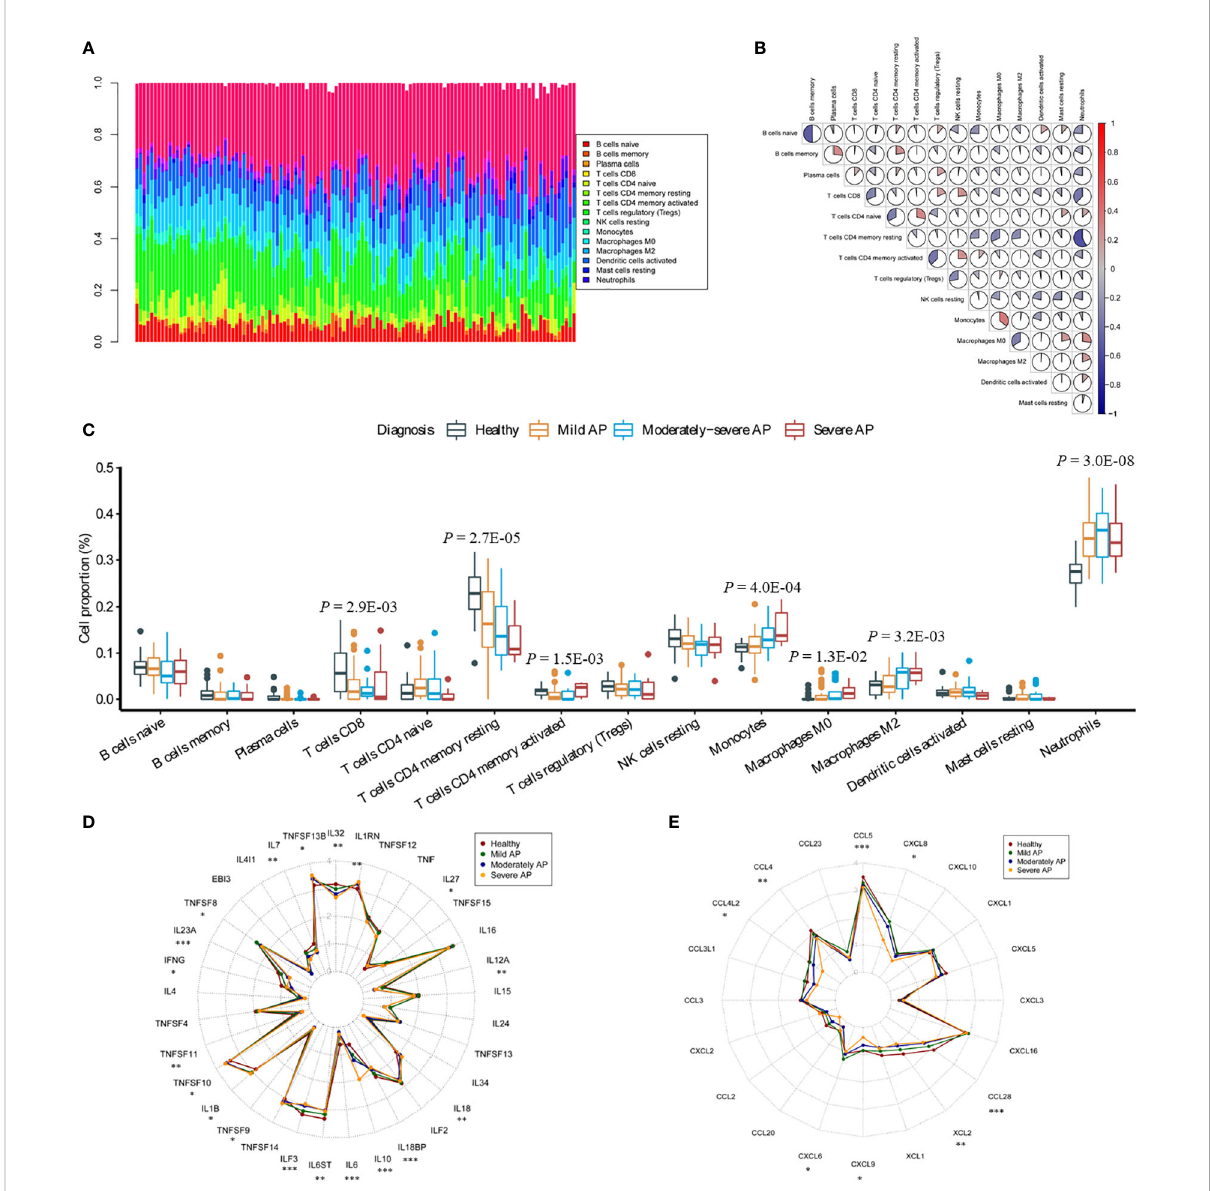
FIGURE 2 Analysis of immune cell in fi ltration and the transcription pro fi le of cytokines and chemokines in AP. (A) The proportions of 22 immune- related cells were assessed through the CIBERSORTx algorithm in AP. The stacking plot indicates the distribution of 22 types of immune cells in AP. (B) The correlation matrix of 22 types of immune cells in AP. (C) Signi fi cant differences among the groups were evaluated utilizing ANOVA. The Y-axis indicates the percentage of immune cells in AP. (D, E) Dot plots represent the expression levels of cytokines and chemokines in the peripheral blood of humans. Asterisks indicate signi fi cant differences, red represents healthy donors, dark green represents MAP patients, dark blue represents M-SAP patients, and dark yellow represents SAP patients (* P < 0.05; ** P < 0.01; *** P <